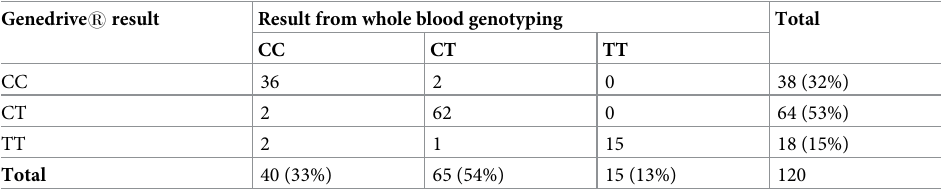
Table 2. Comparisons between Genedrive buccal swab and whole blood genotyping: CC, CT, and TT.